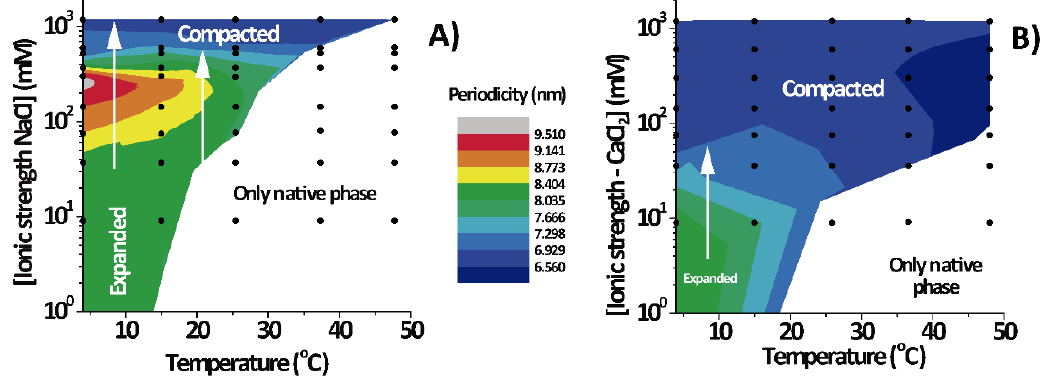
Figure 3. Lamellar period of the non-native phases of PMMs as a function of temperature and IS in aqueous salt solutions based on NaCl ( A ) and CaCl 2 ( B ). The white regions designate sections of the phase diagram in which only the native phase existed. The vertical arrows represent isothermal paths for the transformation expanded into (over)compacted states, and the black dots are the measured data points for each temperature and IS.